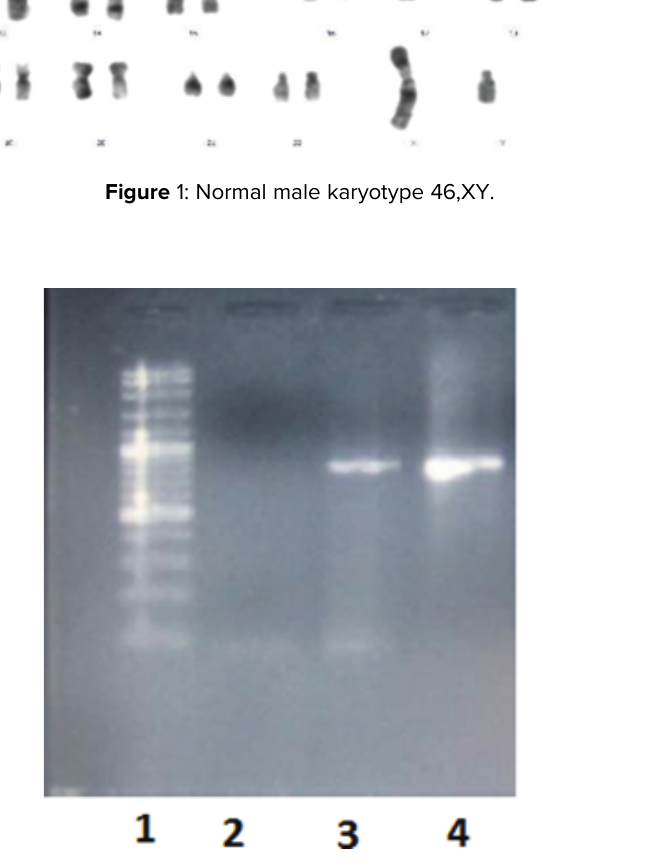
Figure 2: PCR amplification of the SRY gene. From left to right: (lane 1) 100 bp ladder; (lane 2) –ve control (fertile female); (lane 3) +ve control (fertile male), (lane 4)